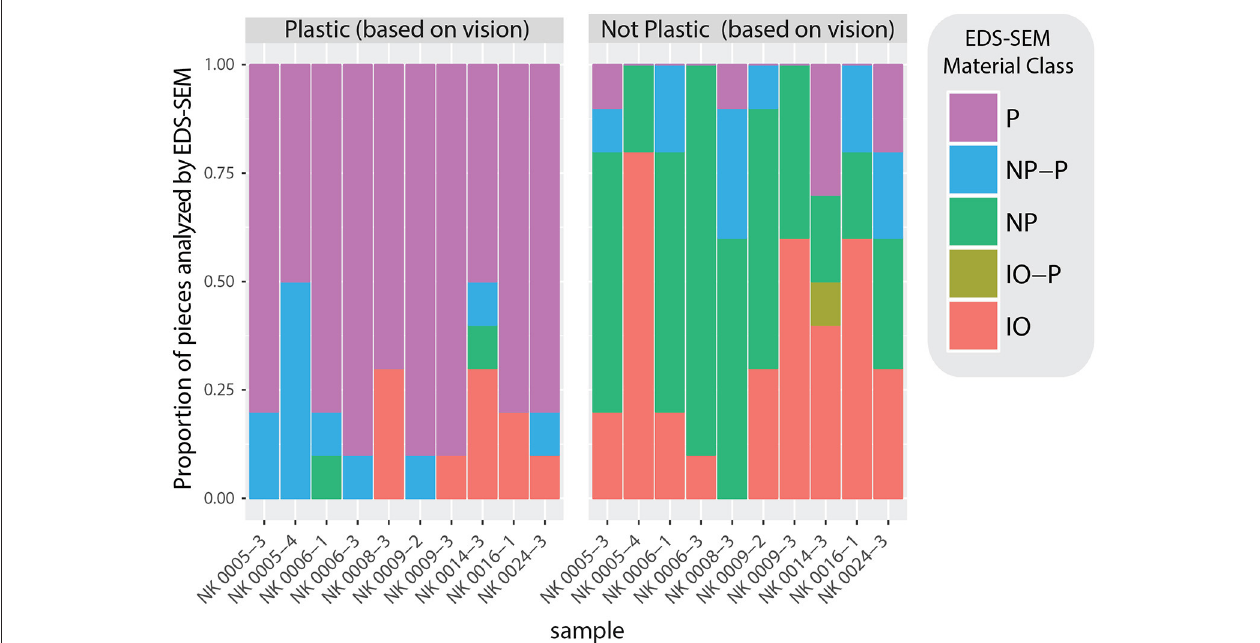
FIGURE 8 | Barplots representing the agreement between visually categorized fragments (plastic vs. non-plastic) and SEM-EDS analytically categorized fragments. SEM-EDS-based classifications fall along a spectrum of three discrete categories: plastic (P), inorganic (IO), and non-plastic organic (NP). This is a visual representation of the contingency table used in the chi-square test of independence (Supplementary Table 1).